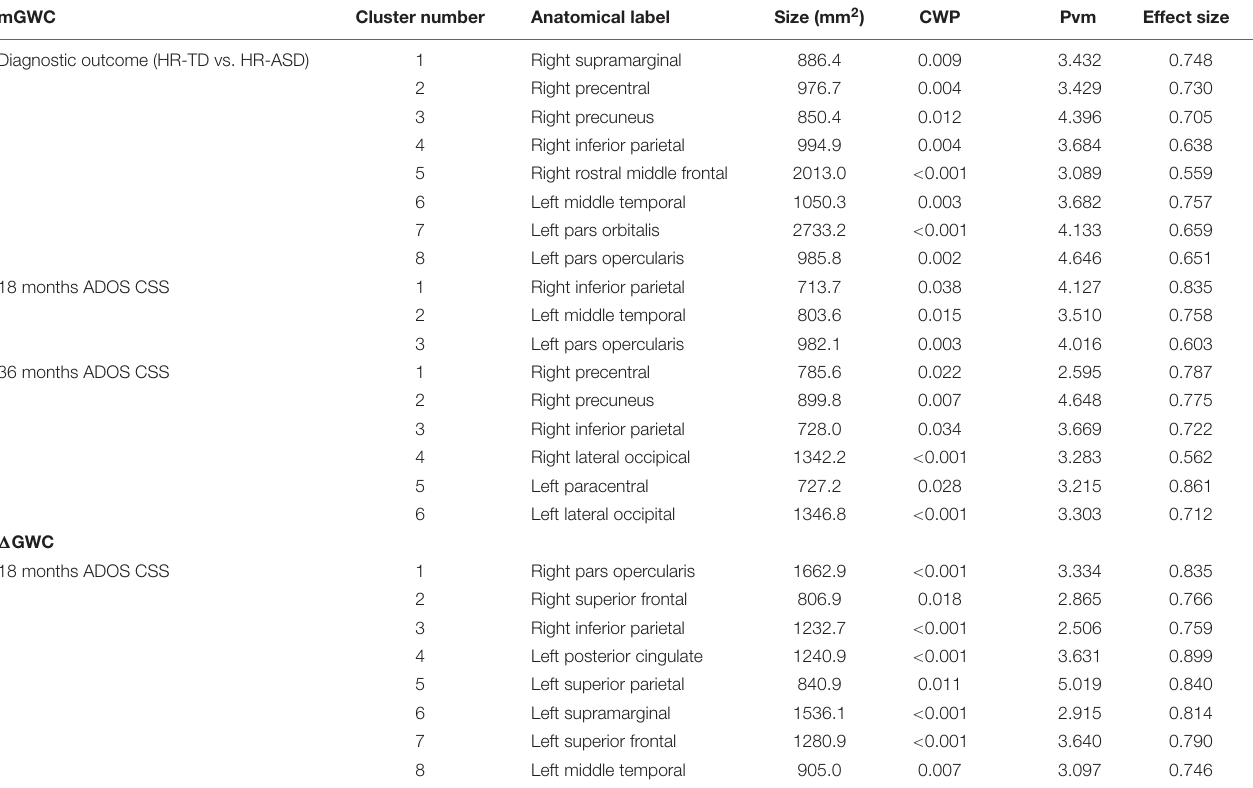
TABLE 2 | Clusters of significant association between GWC and clinical outcomes. mGWC Cluster number Anatomical label Size (mm 2 ) Pvm Effect